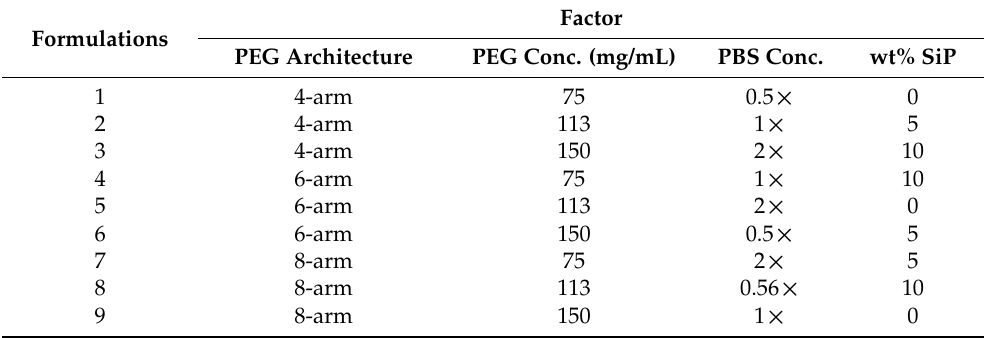
Table 2. Nine adhesive formulations tested to fulfill the robust design matrix requirement.